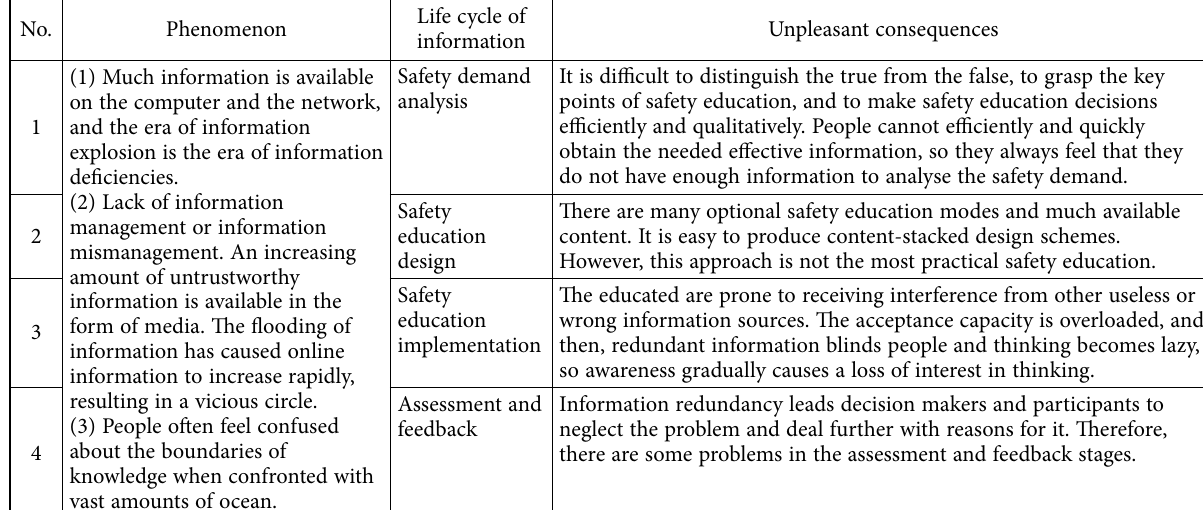
Table 1. Phenomenon of information explosion in the information life cycle of safety education